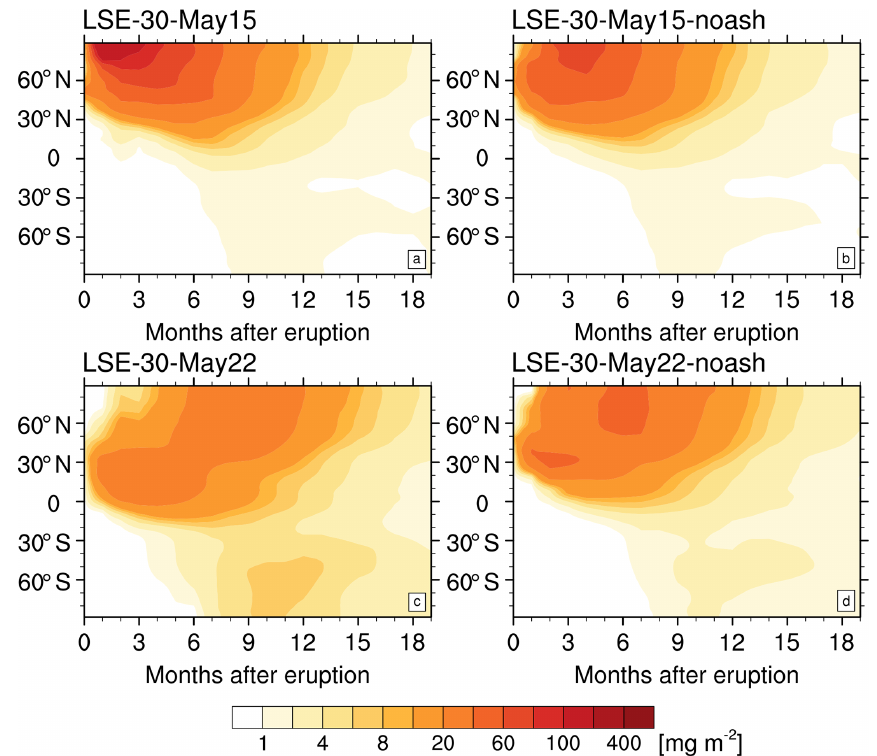
Figure 8. Hovmøller diagram of zonally averaged sulfur burden for an assumed LSE-like eruption over a period of 1.5 years after the first eruption phase. Eruptions take place on 15 (a, b) and 22 May (c, d) with injection of fine ash (a, c) and without the injection of ash (b, c)